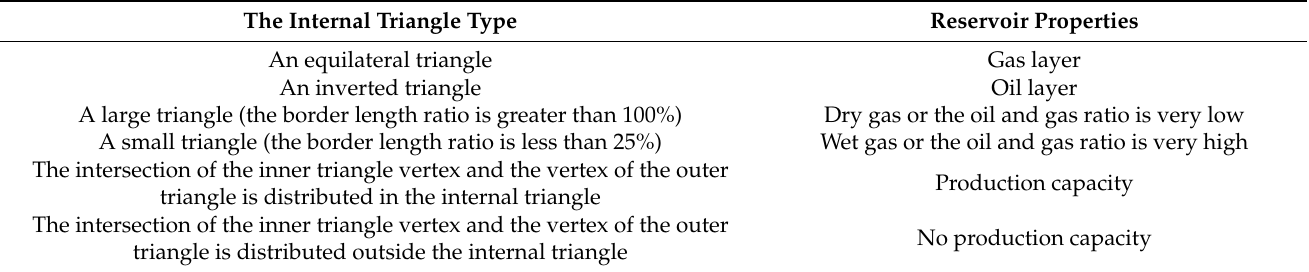
Table 2. The triangle diagram method judgment criteria.